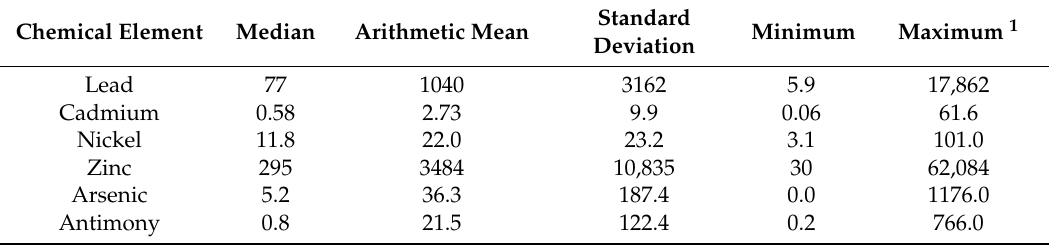
Table 5. The statistical characteristics of toxic elements concentrations (ppm) in the soils of 39 households and surroundings from Santo Amaro City, 2008.